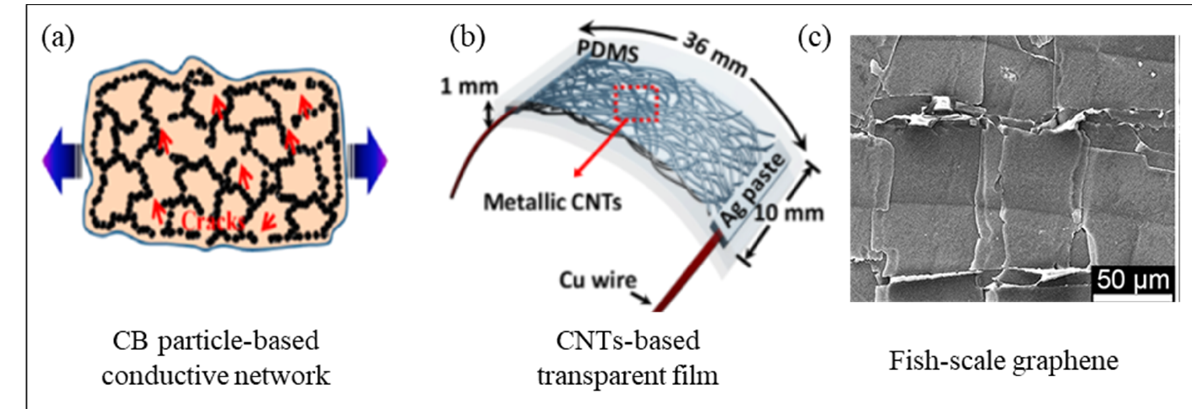
Figure 6. Carbon-type conductive materials.